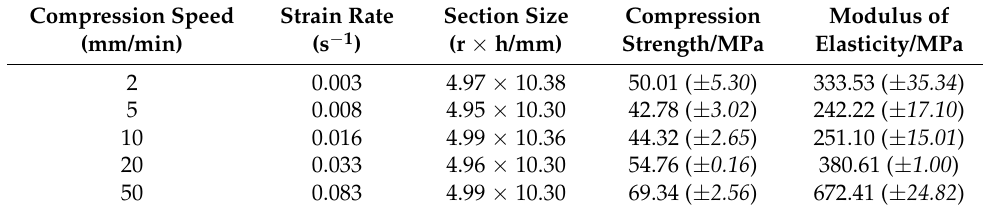
Table 6. PLA quasi ‐ static compression experimental data.